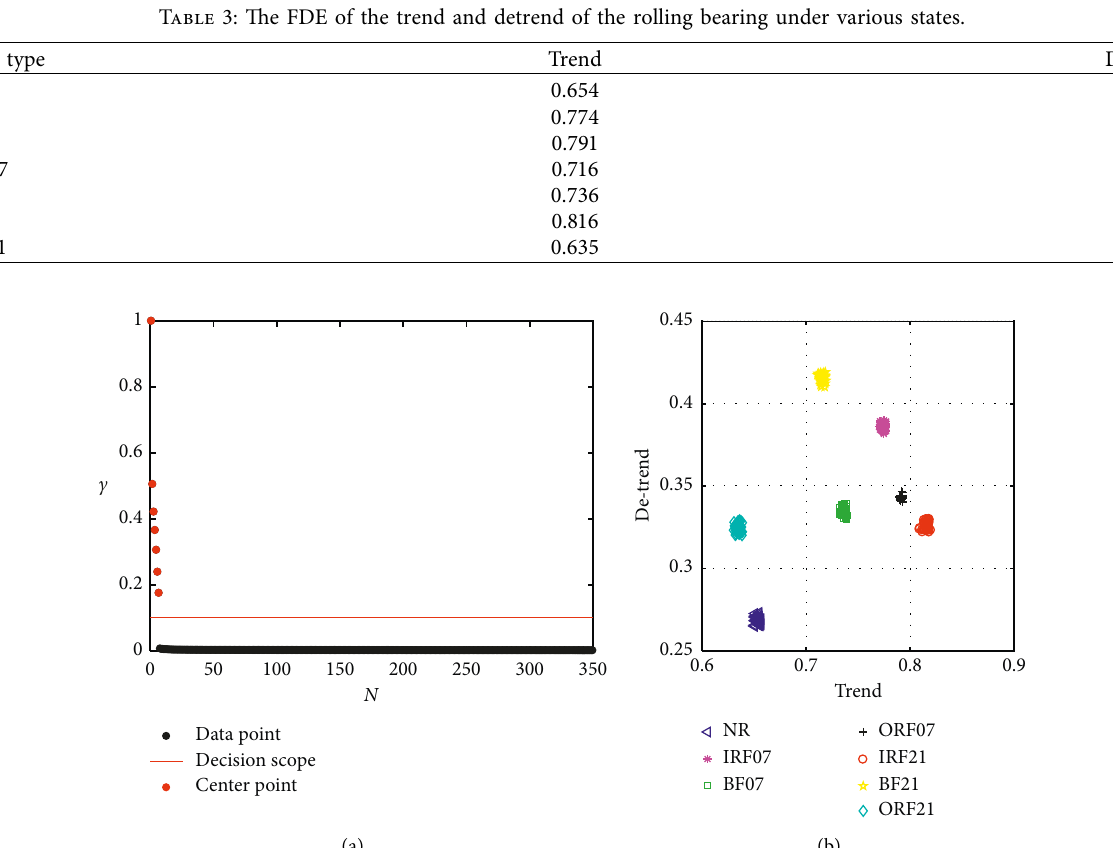
Figure 9: The clustering result of the rolling bearing by using the SPA-FDE-DPC: (a) decision graph and (b) clustering